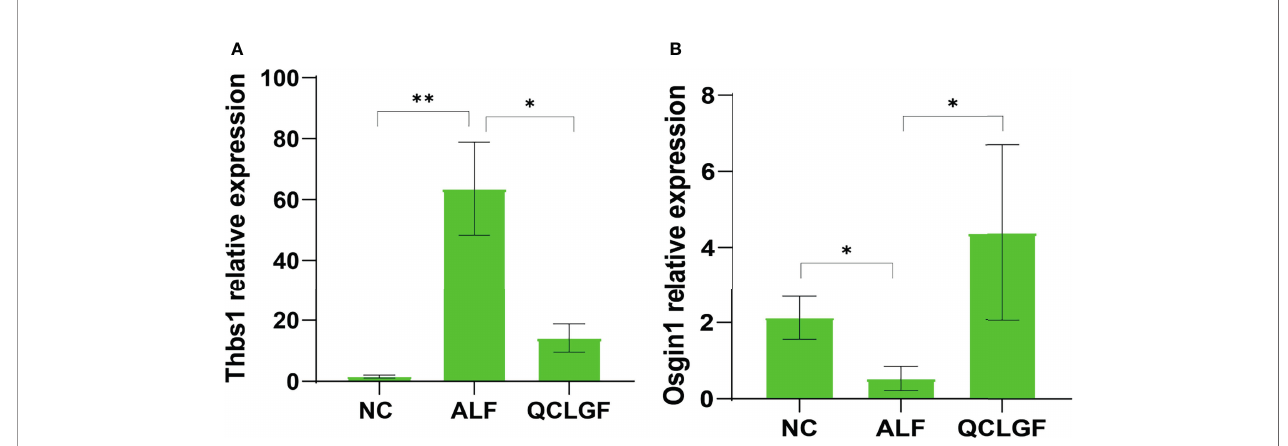
FIGURE 5 | Analysis of expression of DEG genes in rat liver using RT-qPCR. Expression levels of two candidate genes, Osgin1 (A) and Thbs1 (B) were measured. Wilcoxon ranksum test was applied to test the differences in gene expression levels among the three groups. (All data was presented as Mean ± SEM, * P < 0.05; ** P < 0.01. n = 6 samples per